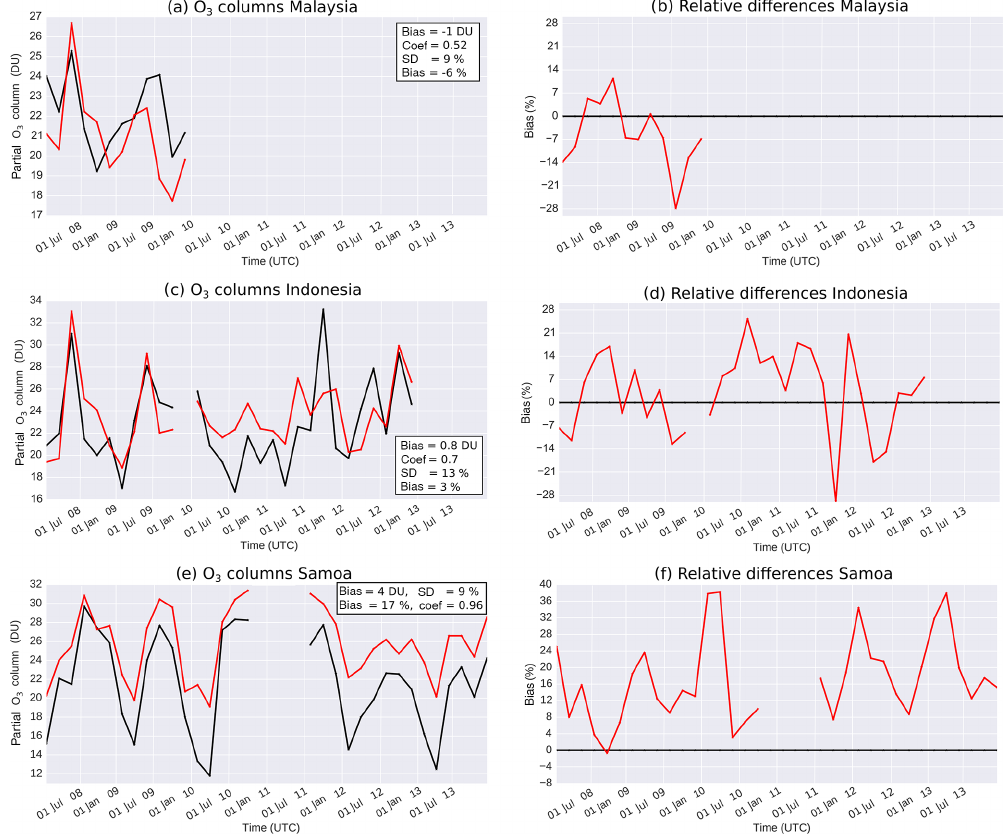
Figure 4. Comparisons between IASI-a (in red) and ozonesondes (in black). Time series of the TCO (in DU) are plotted on the left and relative differences are on the right for the sites of (a, b) Malaysia, (c, d) Indonesia and (e) , (f) Samoa.